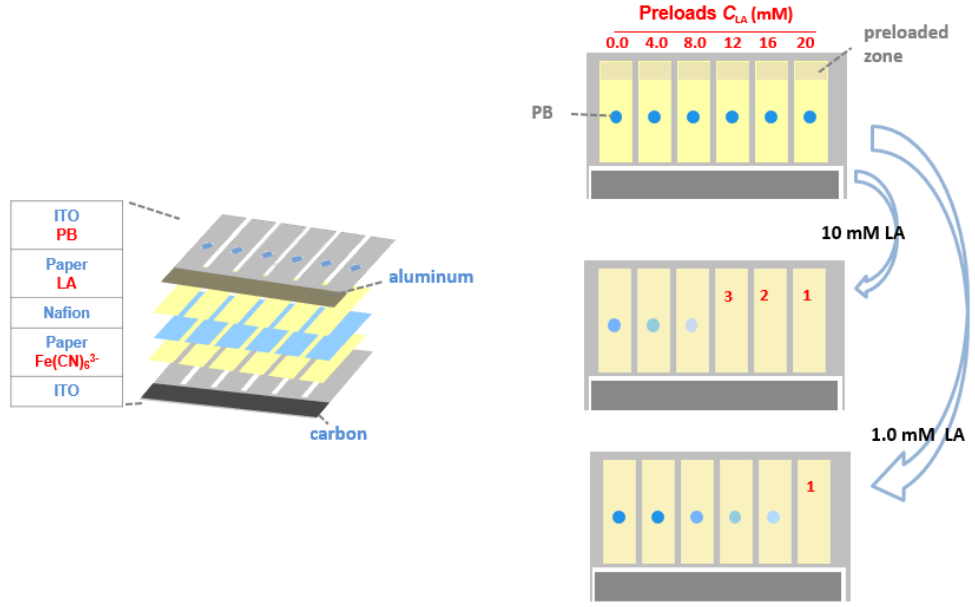
Figure 1. Schematic illustration showing the structure and working principle of the proposed electrochromic sensing array. It consists of two parts: an electrochemical sensor and an aluminum-air battery for powering the sensor. The sensor is composed of two ITO films as electrodes, two pieces of paper as the detection reservoirs and a Nafion film as the ionic conductor. One of the ITO electrodes has electrodeposited PB on it as the electrochromic indicator. The paper reservoir contacted with the PB is preloaded with increasing amounts of standard LA solution (0.0, 4.0, 8.0, 12, 16, 20 mM). The other is preloaded with dried LOx and Fe(CN) 63 − . The catalytic oxidation of LA by LOx results in conversion of Fe(CN) 63 − to Fe(CN) 64 − . Fe(CN) 64 − is then oxidized back to Fe(CN) 63 − on the ITO electrode, resulting in conversion of PB to colorless PW on the ITO electrode. When the concentration of LA exceeds a threshold value, PB can be converted to PW completely. Higher LA concentration leads to more spots that changes color, which enables semiquantitative detection of LA using the naked eye.